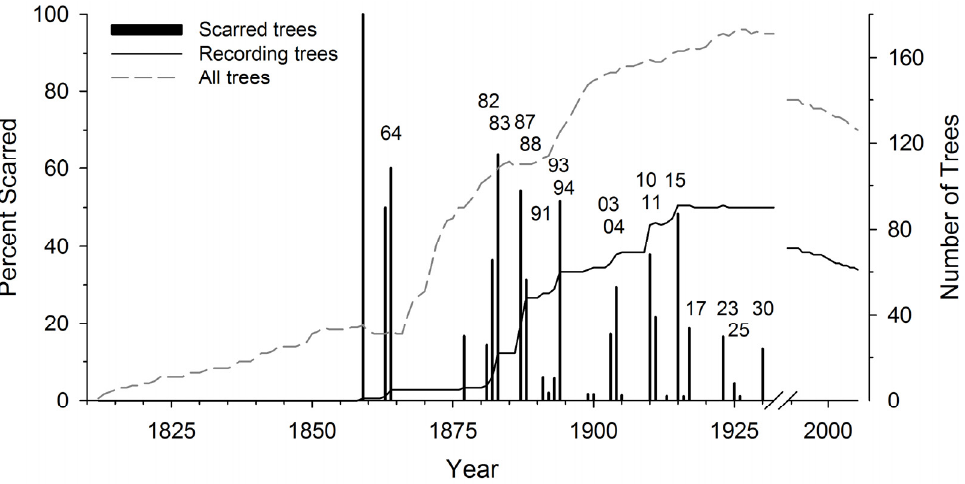
Figure 4. Percent of Pinus banksiana trees scarred per fire year. Sample depth (number of trees) is indicated. Percentage of scarred trees (black bars) is calculated from recorder trees (black line), with all sampled trees in the LKFMU indicated by the dashed grey line. No fire scars recorded by at least two trees were observed prior to 1864 or after 1930. The break in the x -axis from 1932 to 1989 is simply intended to better capture the figure’s